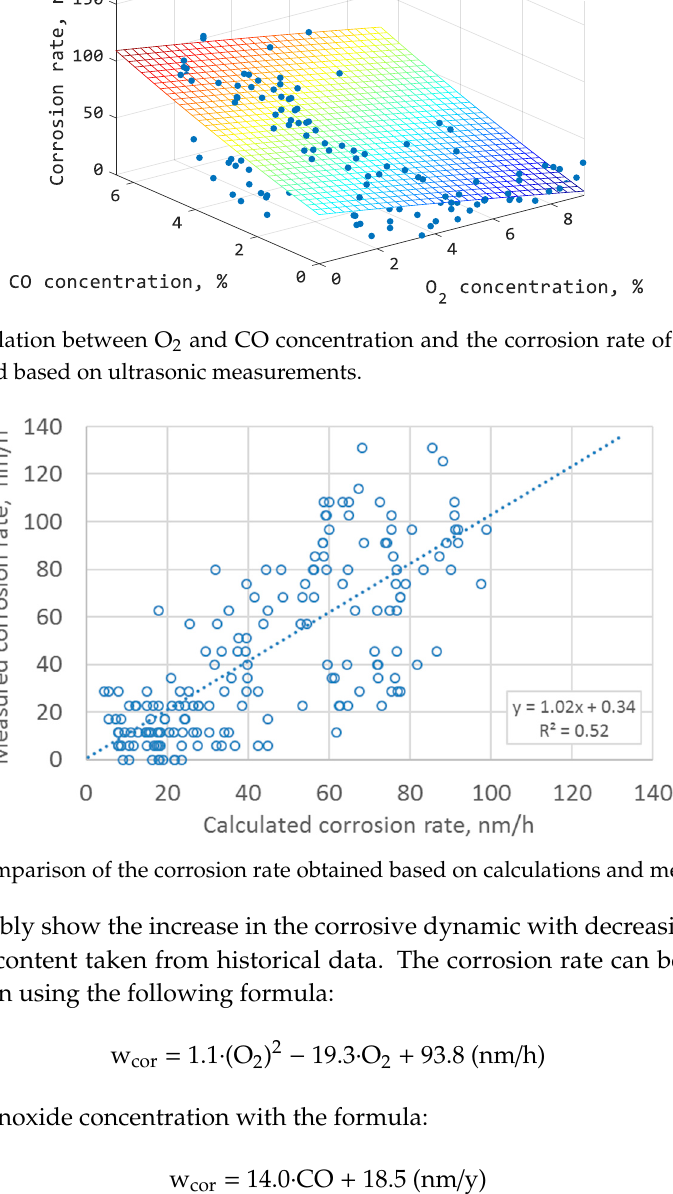
Figure 15. Correlation between O 2 and CO concentration and the corrosion rate of the evaporator tubes, determined based on ultrasonic measurements.